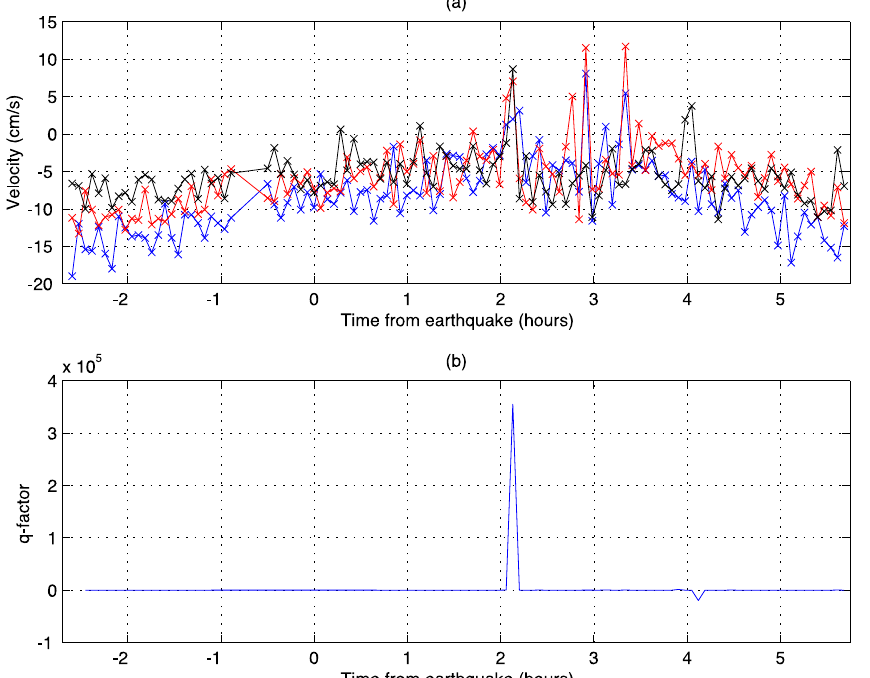
Figure 3. PDNG radar observations 11 April 2012. ( a ) Velocity vs. time from 8:38 UTC. Blue: 0–2 km; Red: 2–4 km; Black: 4–6 km. ( b ) The q-factor corresponding to (a) displaying detections of both tsunamis. ( c ) Velocity vs. time from 8:38 UTC for 2 hours surrounding the arrival of the first tsunami. Blue: 0–2 km; Red: 2–4 km; Black: 4–6 km, showing the typical tsunami velocity arrival signature. ( d ) The q-factor corresponding to (c). ( e ) Velocity vs. time from 8:38 UTC for 2 hours surrounding the arrival of the second tsunami. Blue: 6–8 km; Red: 8–10 km; Black: 10–12 km, showing the typical tsunami velocity arrival signature. ( f ) The q-factor corresponding to